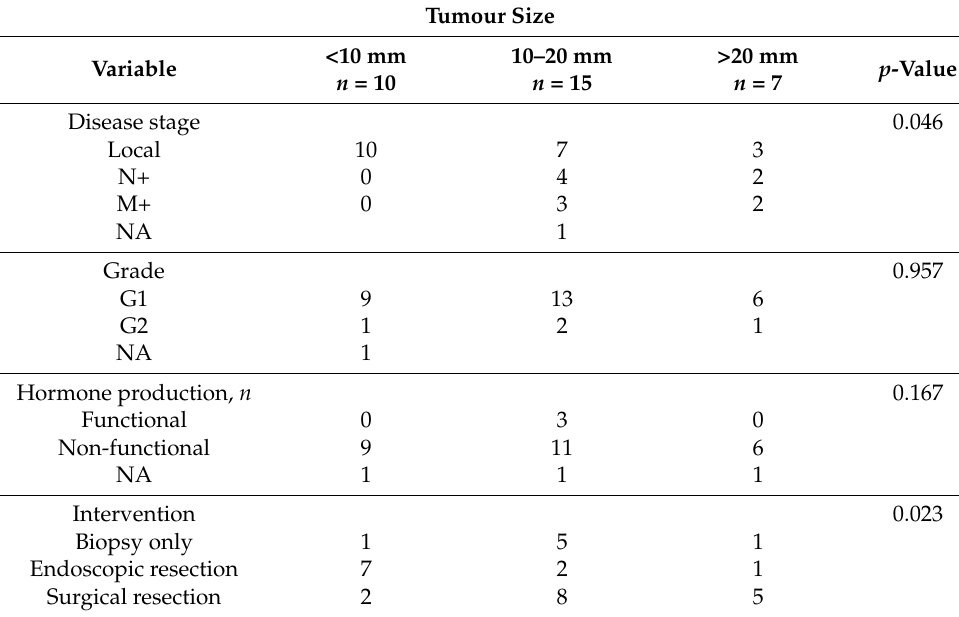
Table 3. Tumour size, disease stage and